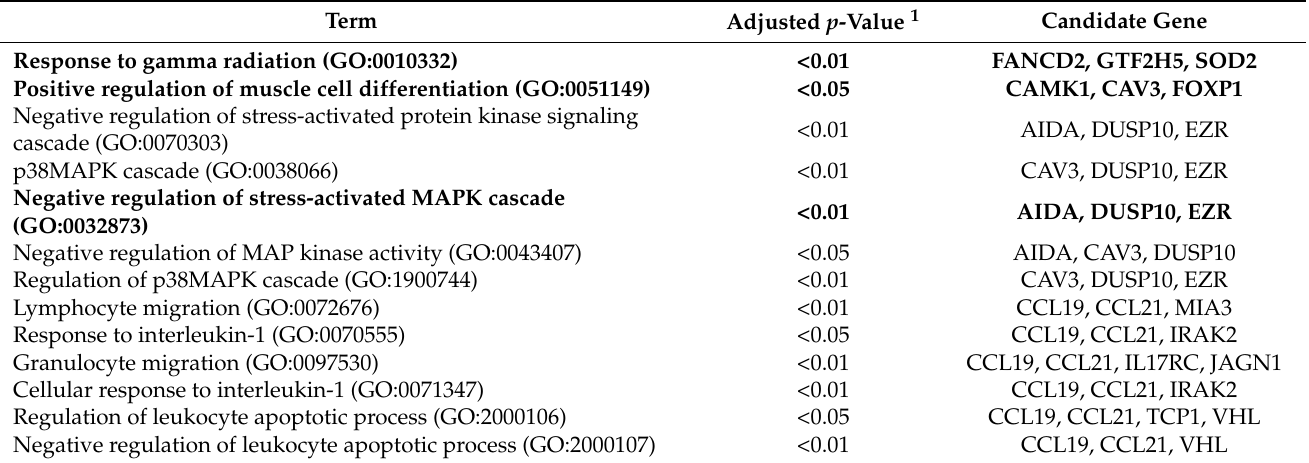
Table 5. Results of GO and KEGG pathway analyses associated with direct genetic effect (DGE) in DUC pigs.